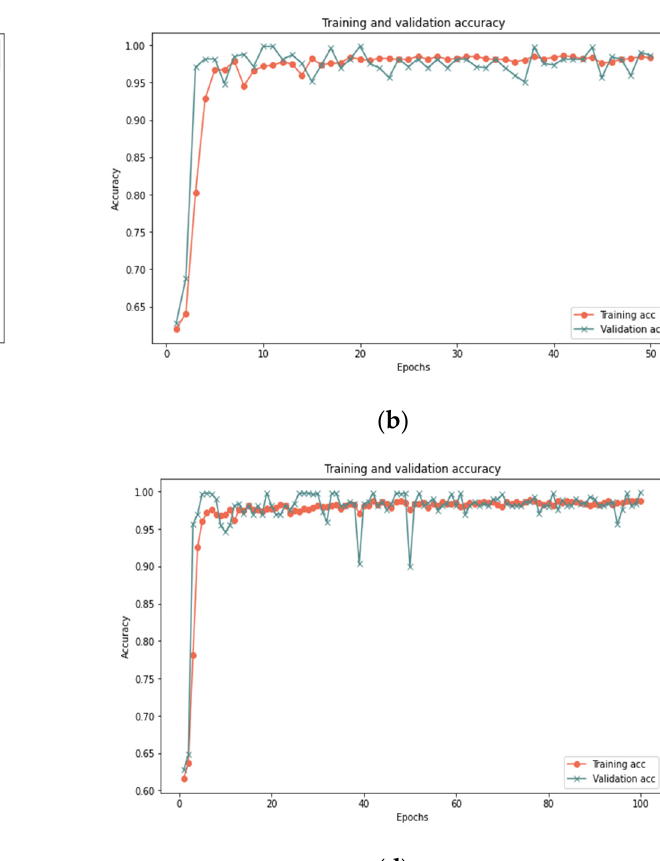
Figure 9. Results of the 25% sample size: ( a ) loss of 50 iterations, ( b ) accuracy of 50 iterations, ( c ) loss of 100 iterations, ( d ) accuracy of 100 iterations.